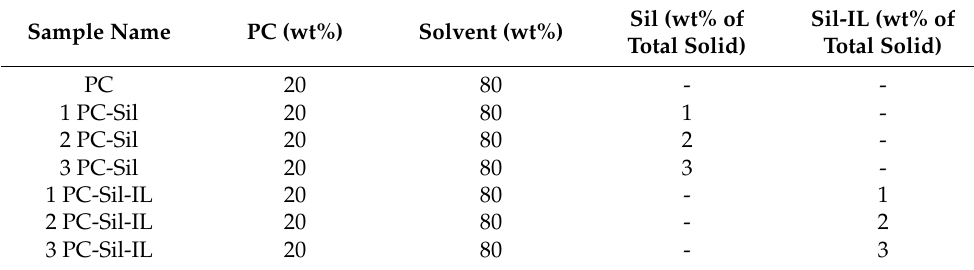
Table 1. Composition of PC, DCM, and inorganic fillers for developed